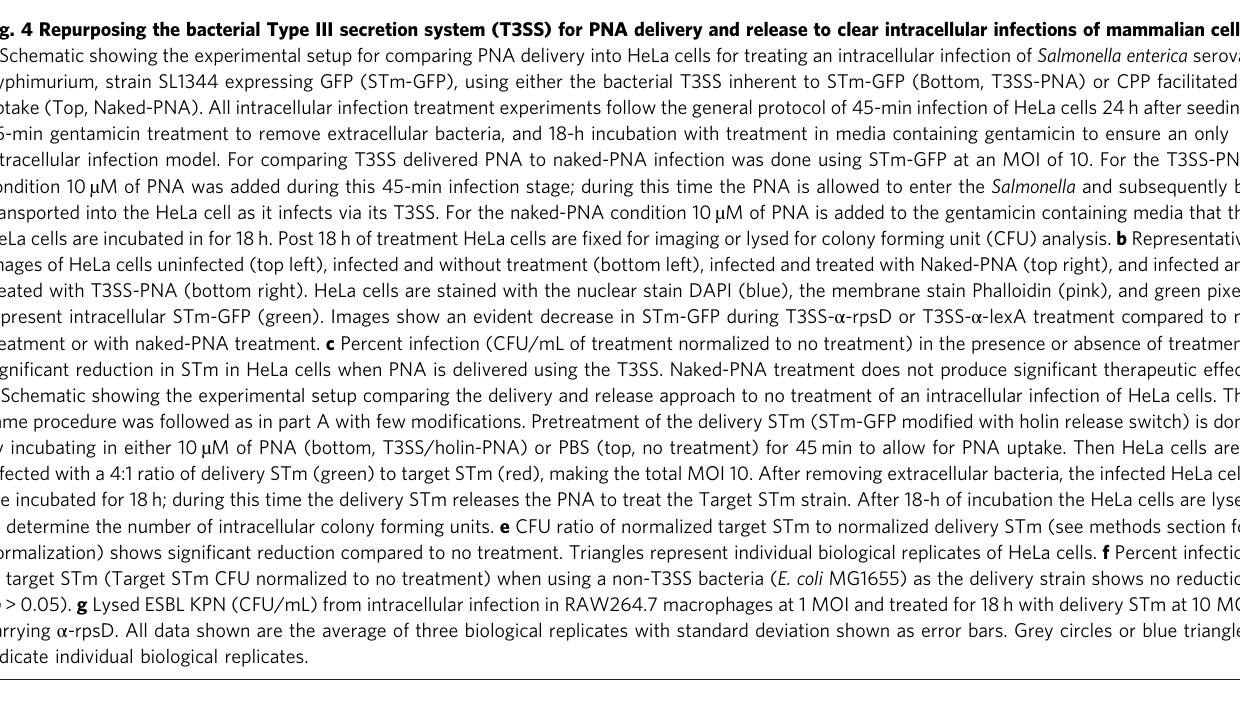
Fig. 4 Repurposing the bacterial Type III secretion system (T3SS) for PNA delivery and release to clear intracellular infections of mammalian cells. a Schematic showing the experimental setup for comparing PNA delivery into HeLa cells for treating an intracellular infection of Salmonella enterica serovar Typhimurium, strain SL1344 expressing GFP (STm-GFP), using either the bacterial T3SS inherent to STm-GFP (Bottom, T3SS-PNA) or CPP facilitated uptake (Top, Naked-PNA). All intracellular infection treatment experiments follow the general protocol of 45-min infection of HeLa cells 24 h after seeding, 75-min gentamicin treatment to remove extracellular bacteria, and 18-h incubation with treatment in media containing gentamicin to ensure an only intracellular infection model. For comparing T3SS delivered PNA to naked-PNA infection was done using STm-GFP at an MOI of 10. For the T3SS-PNA condition 10 µ M of PNA was added during this 45-min infection stage; during this time the PNA is allowed to enter the Salmonella and subsequently be transported into the HeLa cell as it infects via its T3SS. For the naked-PNA condition 10 µ M of PNA is added to the gentamicin containing media that the HeLa cells are incubated in for 18 h. Post 18 h of treatment HeLa cells are fi xed for imaging or lysed for colony forming unit (CFU) analysis. b Representative images of HeLa cells uninfected (top left), infected and without treatment (bottom left), infected and treated with Naked-PNA (top right), and infected and treated with T3SS-PNA (bottom right). HeLa cells are stained with the nuclear stain DAPI (blue), the membrane stain Phalloidin (pink), and green pixels represent intracellular STm-GFP (green). Images show an evident decrease in STm-GFP during T3SS- α -rpsD or T3SS- α -lexA treatment compared to no treatment or with naked-PNA treatment. c Percent infection (CFU/mL of treatment normalized to no treatment) in the presence or absence of treatment. Signi fi cant reduction in STm in HeLa cells when PNA is delivered using the T3SS. Naked-PNA treatment does not produce signi fi cant therapeutic effect. d Schematic showing the experimental setup comparing the delivery and release approach to no treatment of an intracellular infection of HeLa cells. The same procedure was followed as in part A with few modi fi cations. Pretreatment of the delivery STm (STm-GFP modi fi ed with holin release switch) is done by incubating in either 10 µ M of PNA (bottom, T3SS/holin-PNA) or PBS (top, no treatment) for 45 min to allow for PNA uptake. Then HeLa cells are infected with a 4:1 ratio of delivery STm (green) to target STm (red), making the total MOI 10. After removing extracellular bacteria, the infected HeLa cells are incubated for 18 h; during this time the delivery STm releases the PNA to treat the Target STm strain. After 18-h of incubation the HeLa cells are lysed to determine the number of intracellular colony forming units. e CFU ratio of normalized target STm to normalized delivery STm (see methods section for normalization) shows signi fi cant reduction compared to no treatment. Triangles represent individual biological replicates of HeLa cells. f Percent infection of target STm (Target STm CFU normalized to no treatment) when using a non-T3SS bacteria ( E. coli MG1655) as the delivery strain shows no reduction ( p > 0.05). g Lysed ESBL KPN (CFU/mL) from intracellular infection in RAW264.7 macrophages at 1 MOI and treated for 18 h with delivery STm at 10 MOI carrying α -rpsD. All data shown are the average of three biological replicates with standard deviation shown as error bars. Grey circles or blue triangles indicate individual biological